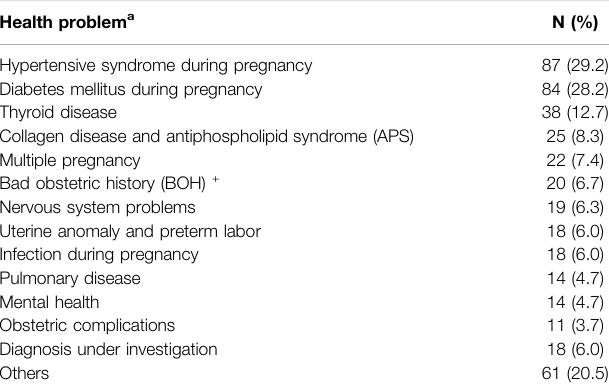
TABLE 2 | Main health problems presented by pregnant women.